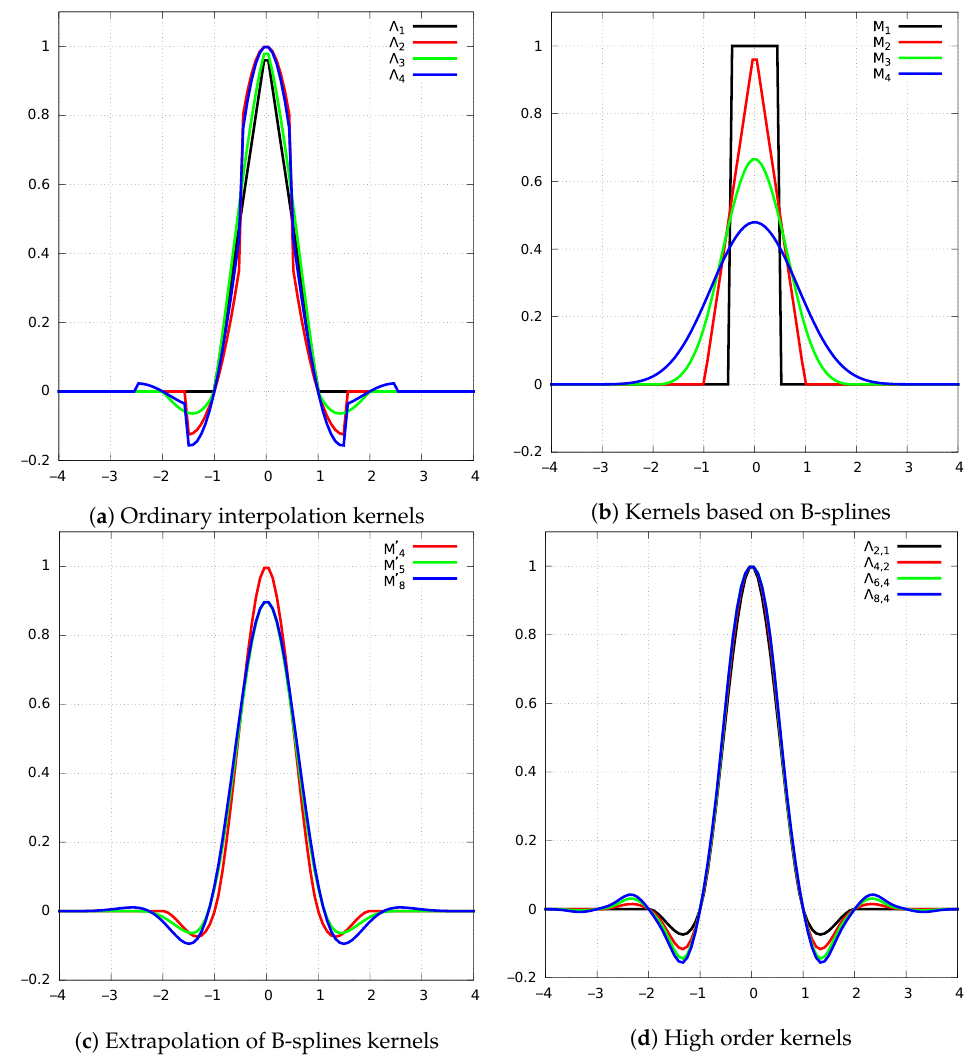
Figure 2. Graphical representation of the different families of remeshing kernels. For each family, several kernels of different orders are plotted (these plots have been constructed from the equations given in Section